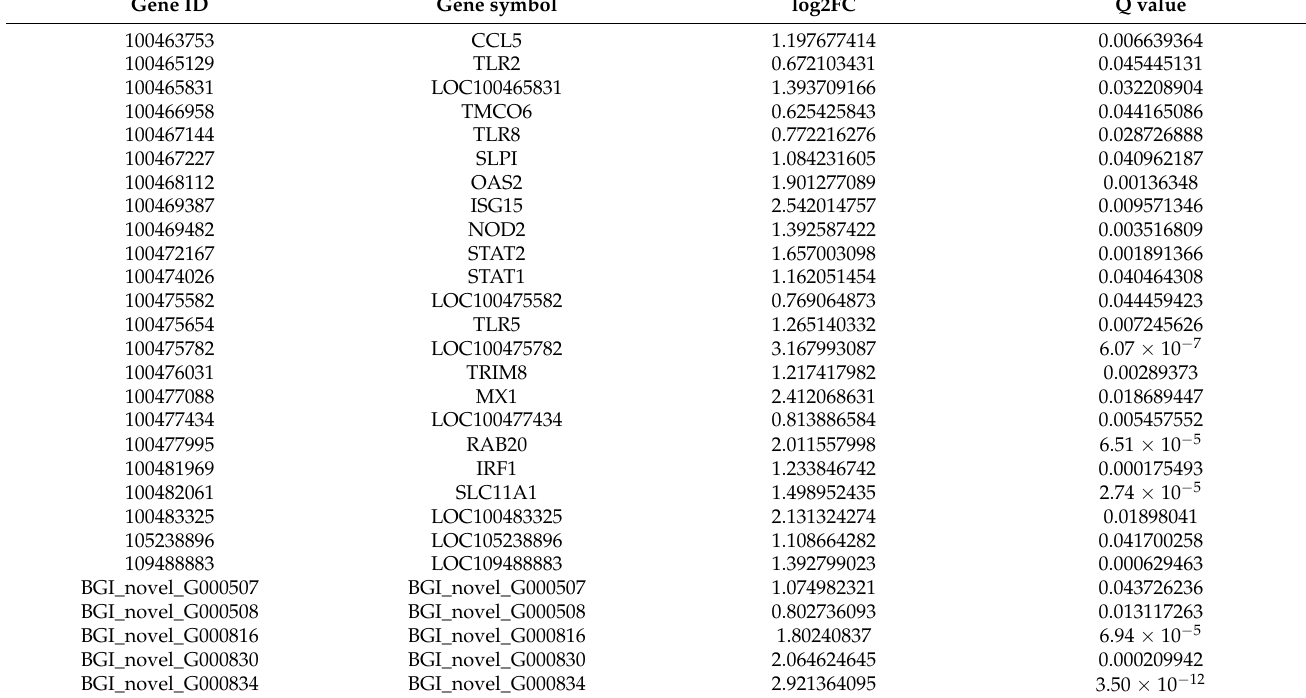
Table 2. Upregulated innate immune genes in the elderly giant pandas.